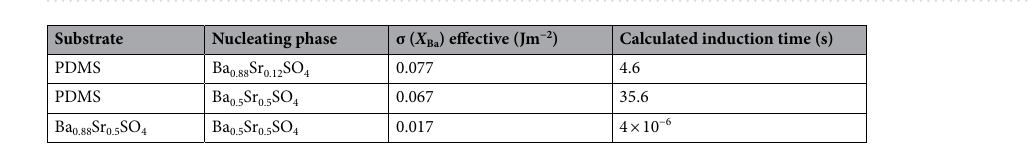
Table 1. Calculated effective surface tension σ ( X Ba ) for different substrates and nucleating phases and calculated induction times 41 .